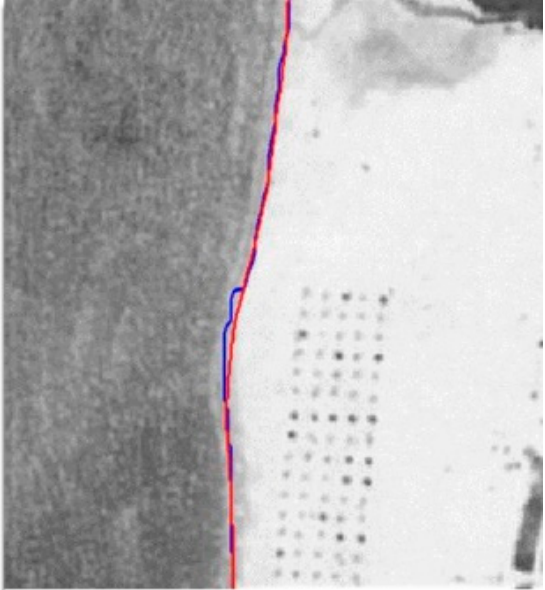
Figure 9. A close-up of the coastline with a better view of the estimation improvements.